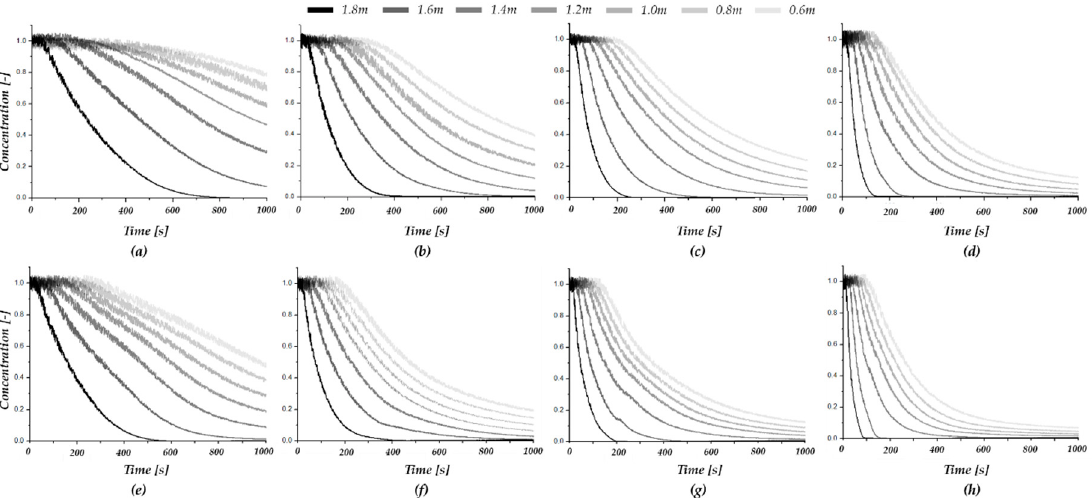
Figure 6. Concentration change according to time and enclosure height for each condition. Lighter shade indicates a decrease in the height, at which point the concentration was measured ( c mix = 1, c air = 0 ) : ( a ) IG-01 , 4 holes; ( b ) IG-01 , 8 holes; ( c ) IG-01 , 12 holes; ( d ) IG-01 , 16 holes; ( e ) HFC-125 , 4 holes; ( f ) HFC-125 , 8 holes; ( g ) HFC-125 , 12 holes; and ( h ) HFC-125 , 16 holes.